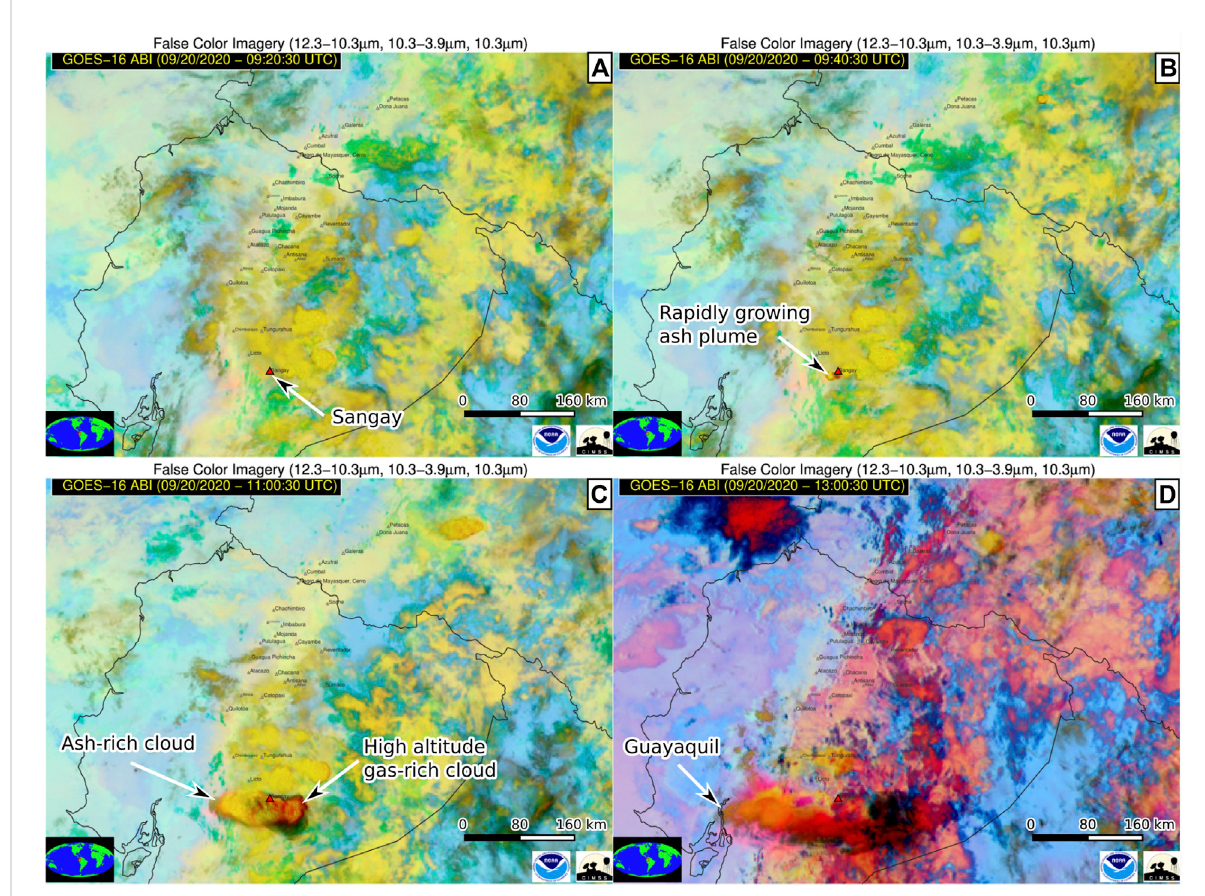
FIGURE 4 False color imagery (satellite GOES-16) of the September 20, 2020 eruptive pulse at Sangay volcano (source: NOAA/CIMSS). (A) Small ash emission at 09:20 UTC; (B) rapidly growing ash plume at 09:40 UTC; (C) separation of the high-altitude gas-rich cloud (to the east) and the ash-rich cloud (to the west) at 11:00 UTC; (D) ash cloud reach Guayaquil city at 13:00